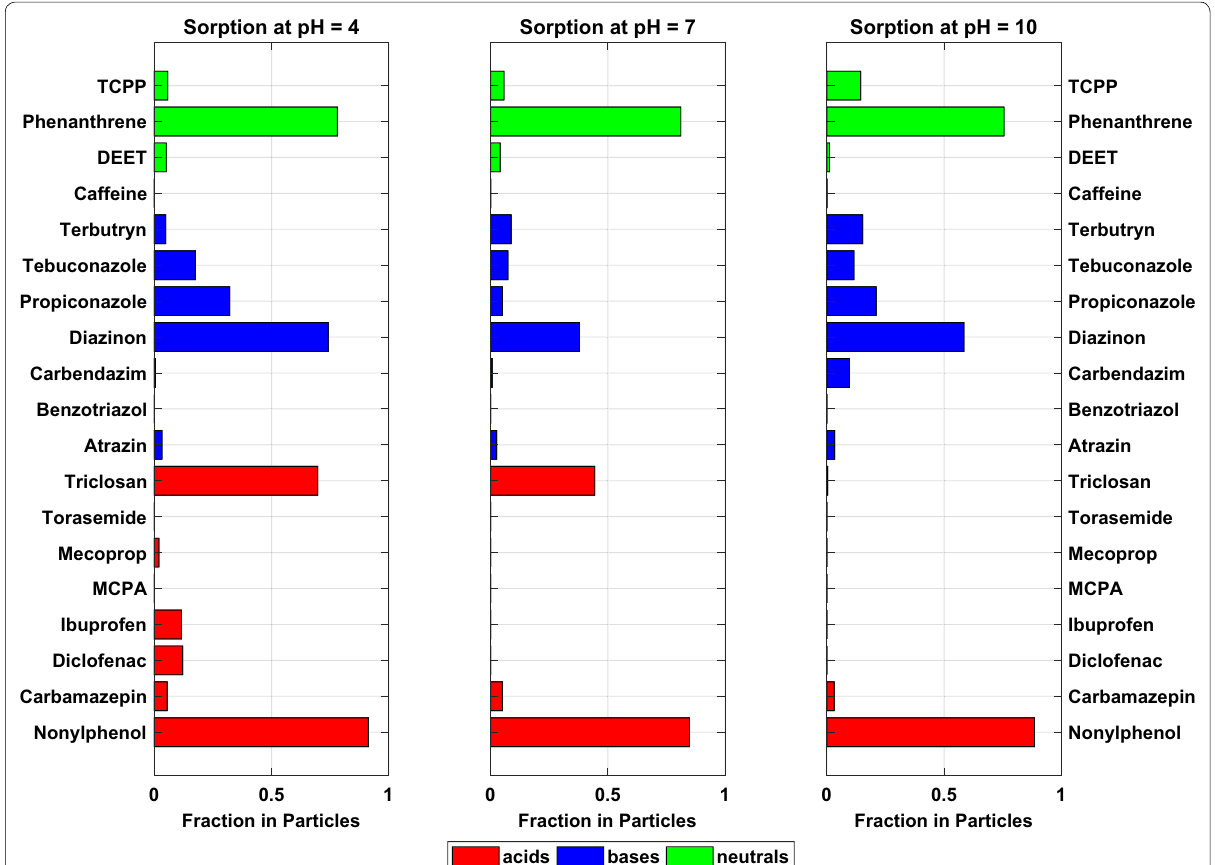
Fig. 2 Sorbed fractions of the investigated contaminants to polystyrene at different pH levels. The bars are colored according to the acid/base properties of the substances as indicated in the legend. For substances for which a negative D P has been determined, the sorbed percentage was set to